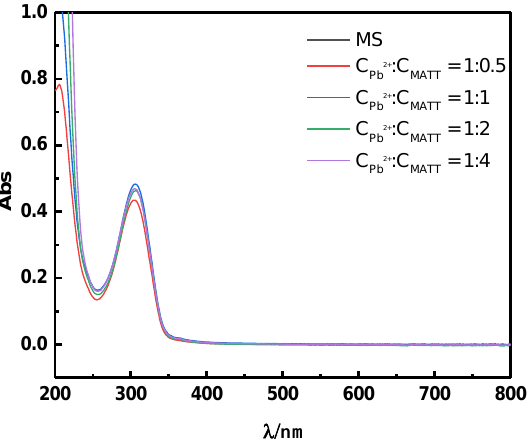
Figure 7. UV spectra of MATT under various concentration ratios of Pb 2+ ions and MATT.